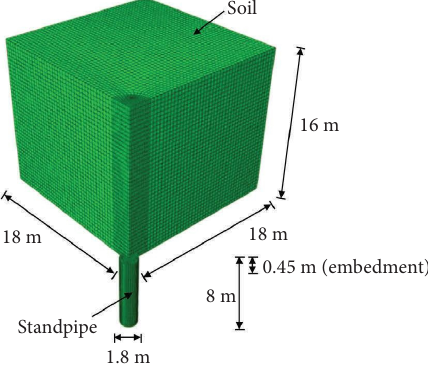
Figure 5: Numerical model.